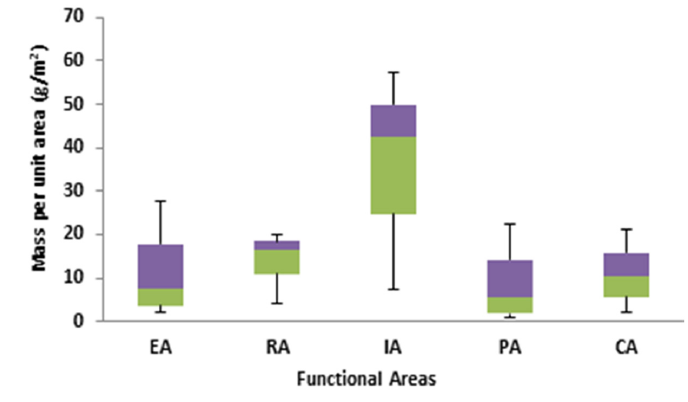
Figure 5. Box plot of the amount of RDS in functional areas.